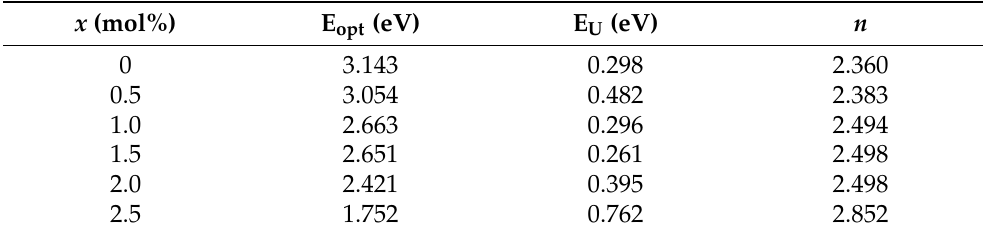
Table 2. Indirect optical energy band gap (E opt ), Urbach energy (E U ) and refractive index ( n )